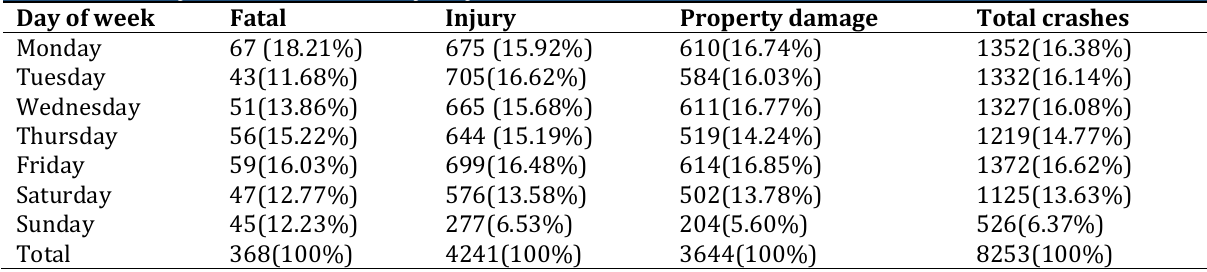
Table 2: Heavy vehicle crashes by days of the week